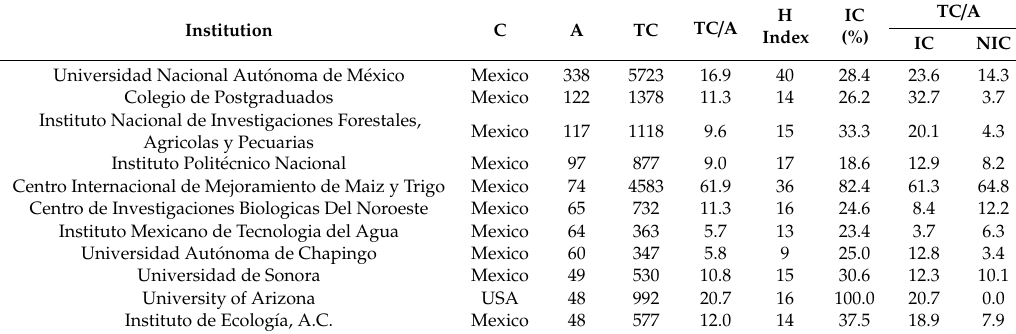
Table 6. Major characteristics of the most active institutions related to AWMM research.